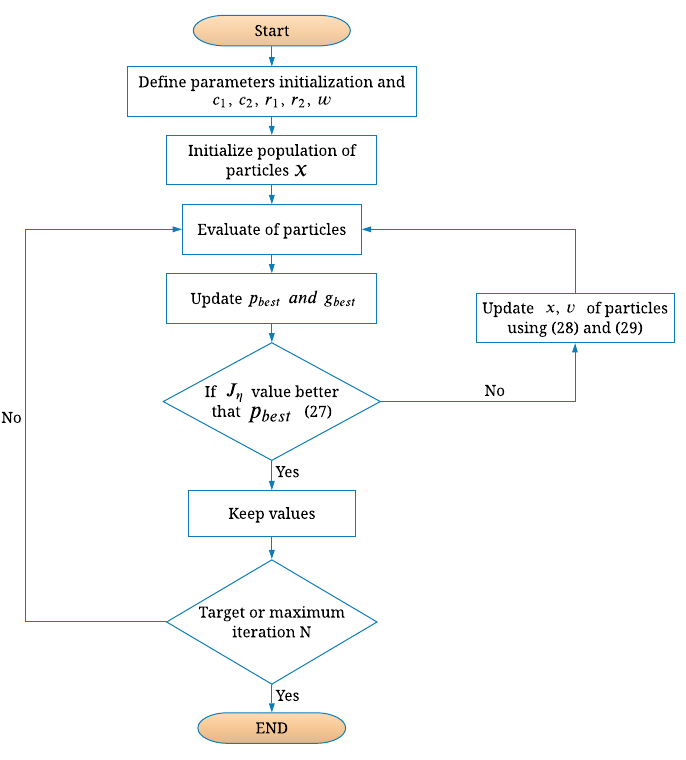
Figure 12. PSO Algorithm